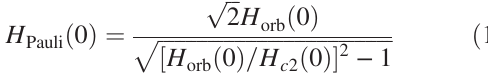
∝ Δ — a measure of the pairing =T 0 =T c c Pauli ð 0 Þ =T ¼ 1 . 84 T = K, c Pauli